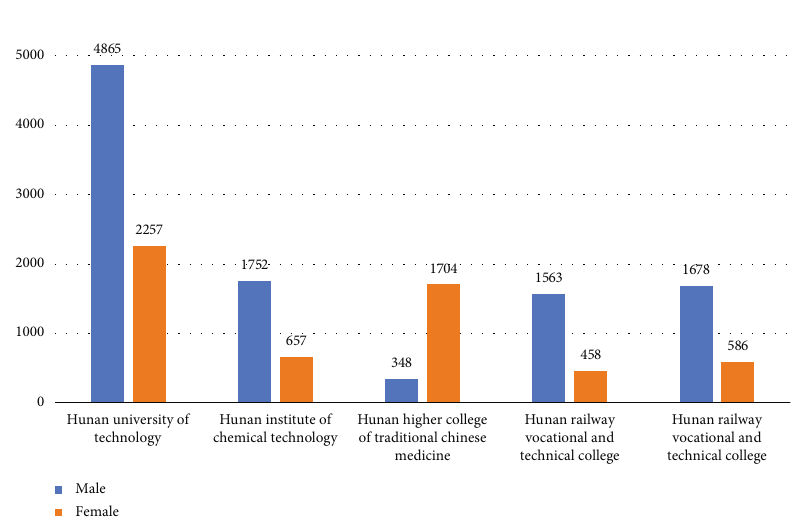
Figure 1: Number of students from Hunan universities in class